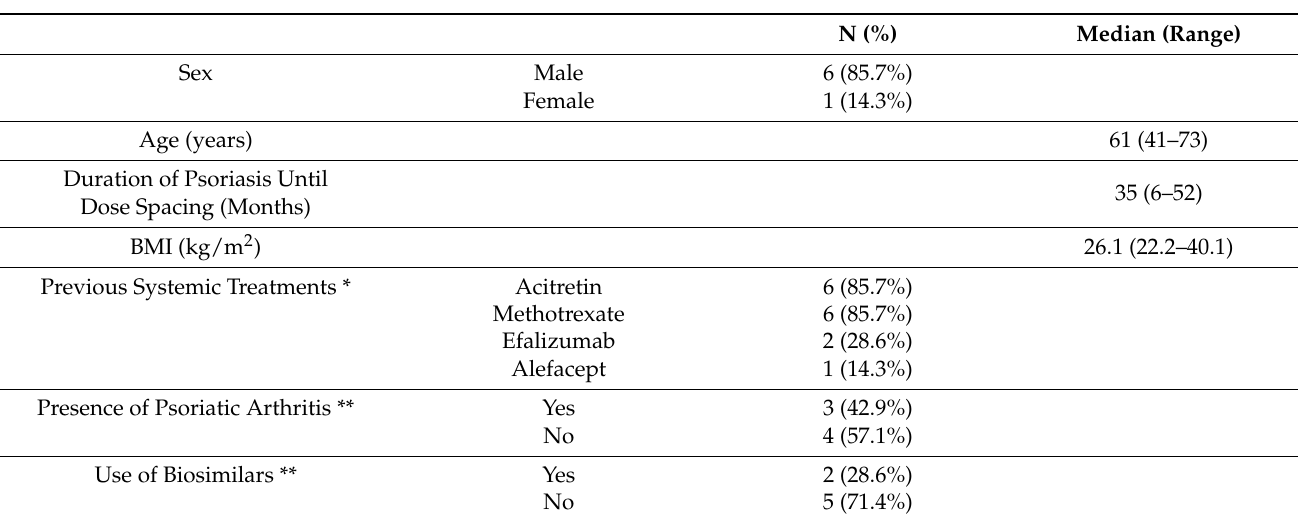
Table 1. Patient